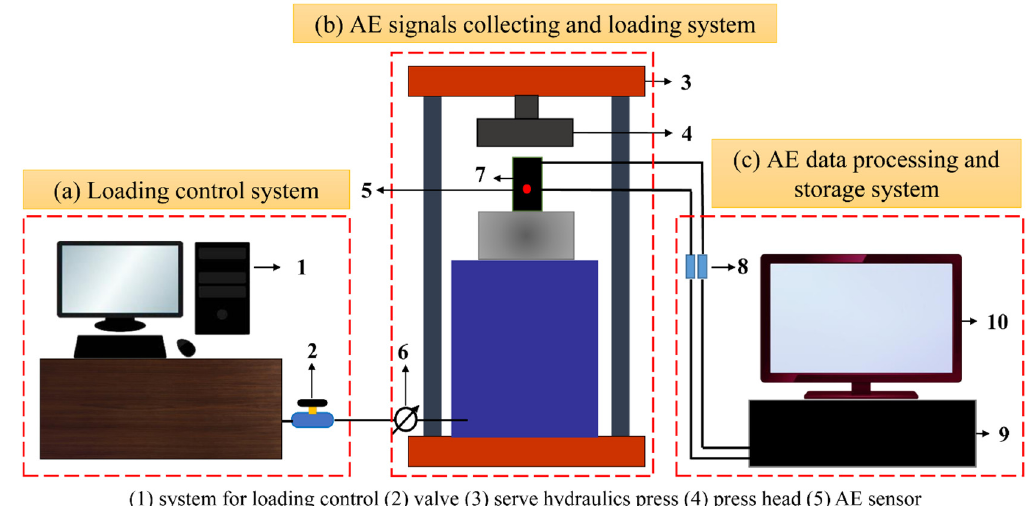
Figure 2. Experimental setup of the research.